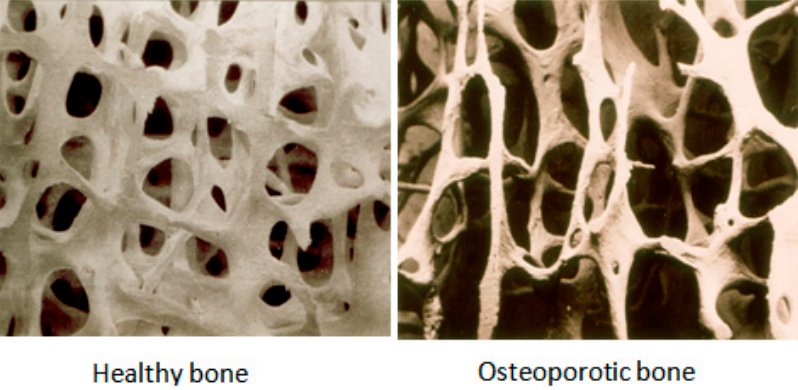
Figure 1. Depicting healthy bone and osteoporotic bone [7].